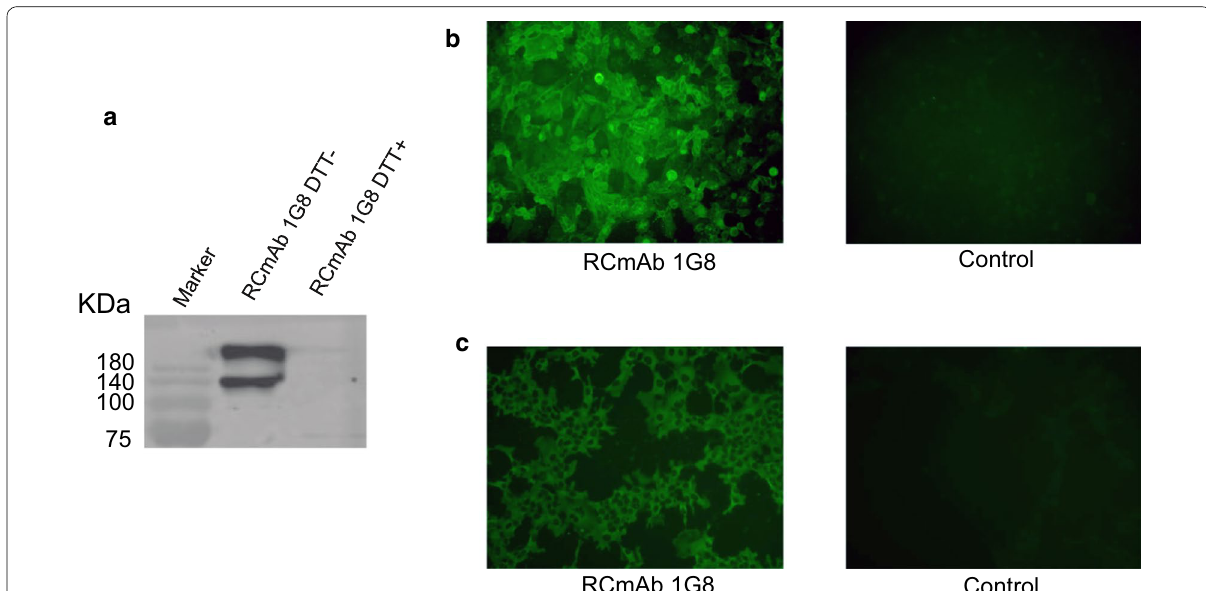
Fig. 2 Production of RCmAb 1G8 against the NA of X1 virus. a Western blot analysis of the RCmAb 1G8 in the supernatant. Non-reducing sample (DTT ) and reducing sample (DTT ) of RCmAb 1G8 were tested. b IFA result of the RCmAb 1G8 reacting with X1 virus-infected MDCK cells. The − + supernatant of COS-1 cells transfected with pCAGGS was used as primary antibody in negative control. c IFA result of the RCmAb 1G8 reacting with pCAGGS-NA (X1) plasmid-transfected COS-1 cells. The supernatant of COS-1 cells transfected with pCAGGS was used as primary antibody in negative